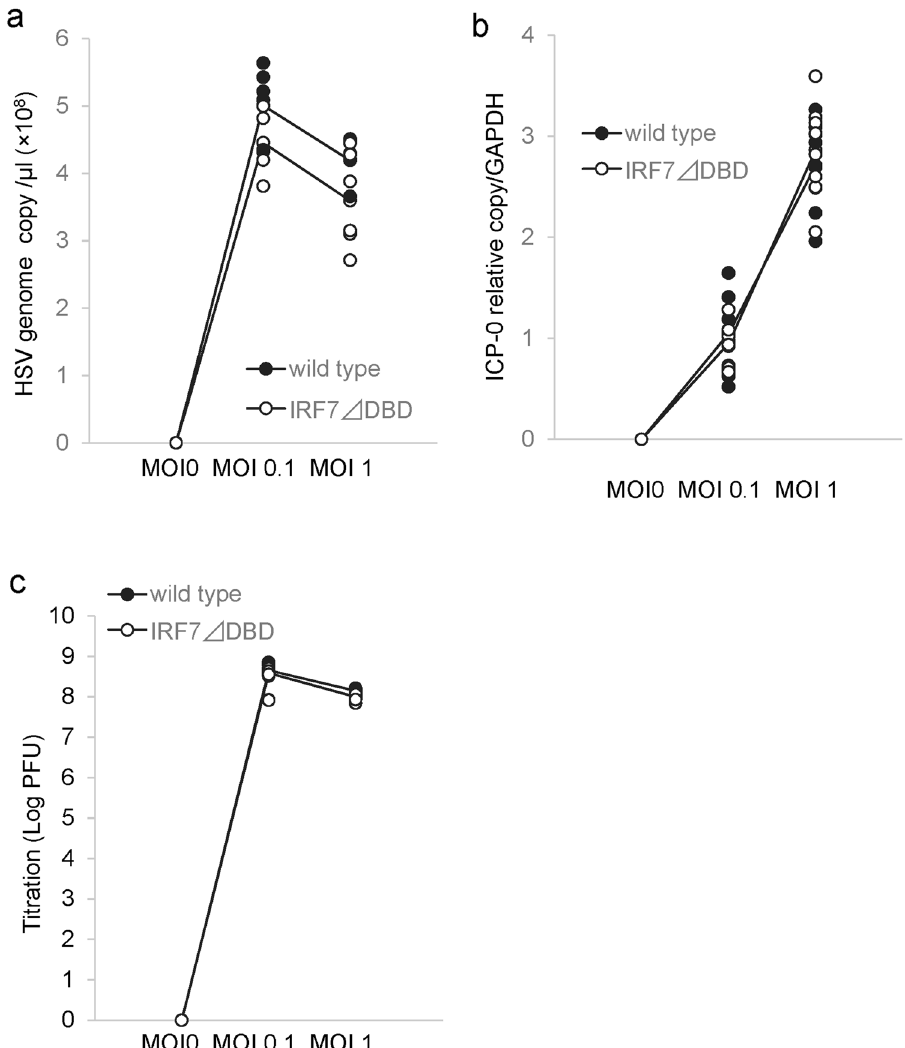
Figure 3. Unperturbed viral replication by IRF7 in corneal endothelial cells. ( a ) The level of HSV-1 DNA in HCEn cells was determined at 24 h after the infection using real-time PCR. The amount of HSV-1 DNA is not reduced for IRF7-competent wild type HCEn cells. N = 6. ( b ) Transcript of an immediately early gene infected cell protein 0 ( ICP0 ) of HSV-1, was evaluated in HCEn cells at 12 h after infection using real-time RT-PCR. ICP-0 induction is not perturbed for IRF7-competent wild type HCEn cells. N = 8. ( c ) Titration plaque assay for HCEn cells after infection. The HSV-1 titer is not perturbed for IRF7-competent wild type HCEn cells. N =